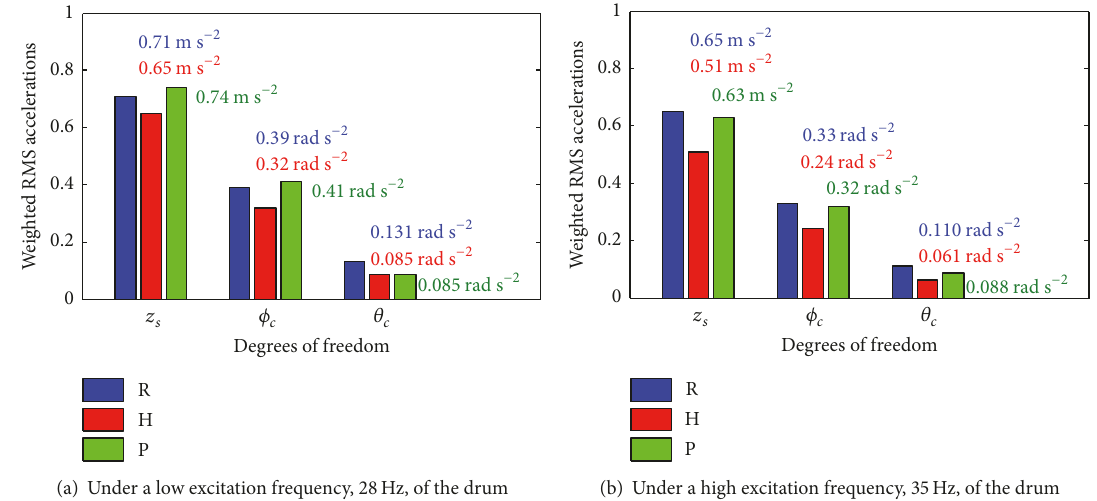
Figure 14: The weighted RMS acceleration responses on a high-density soil